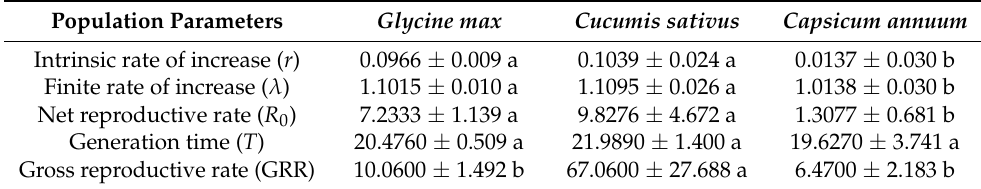
Table 2. Population parameters of Thrips flavus fed on different